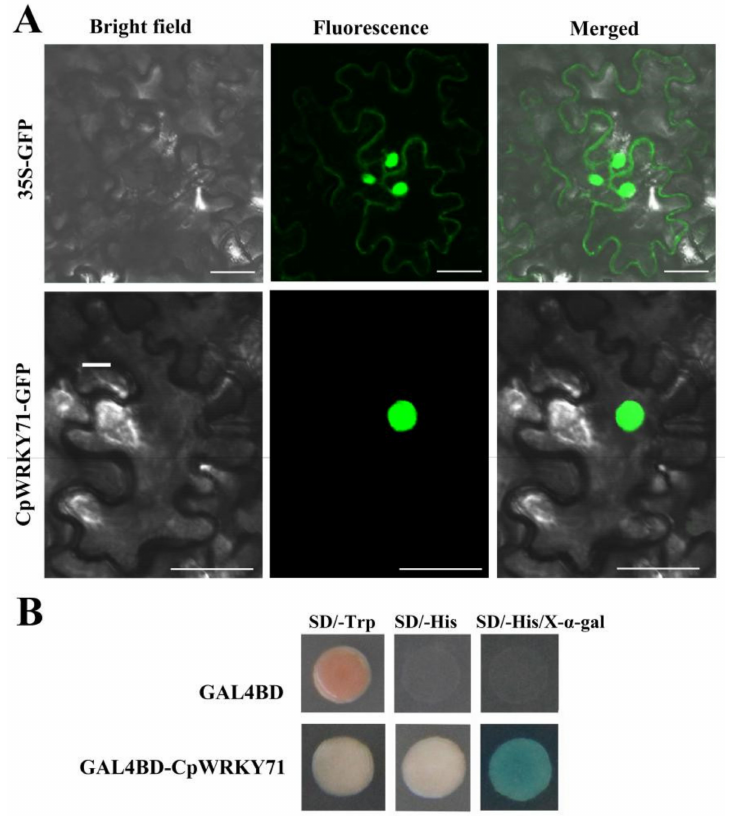
Figure 3. Subcellular localization and transactivation assay of CpWRKY71. ( A ) Subcellular localization of CpWRKY71 protein in tobacco leaf epidermal cells. 35S:GFP was used as the control. A confocal microscope was used to observe green fluorescence. Bars denote 50 µ m. ( B ) Transactivation assay of CpWRKY71. The plasmid of pGBKT7- CpWRKY71 was transformed into AH109 yeast strain, and examined on SD / Trp-, SD / -His (containing 10 mM 3-AT) and SD / -His / X- α -gal (containing 10 mM 3-AT) mediums. pGBKT7 was used as the